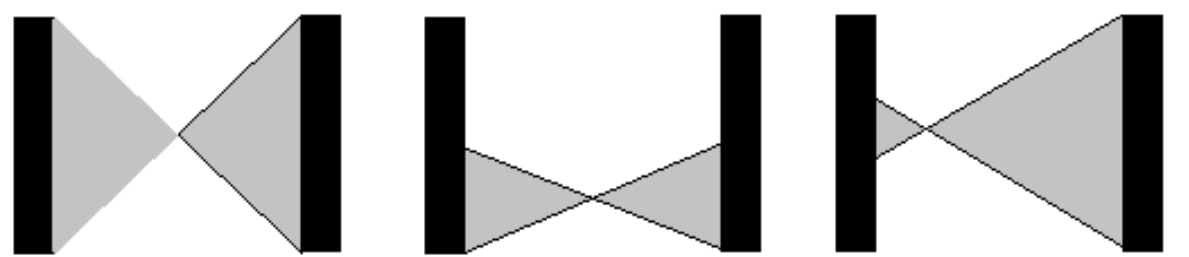
Figure 1. The solid angle for detecting pairs of back-to-back photons is maximum for a source at the centre of the FOV ( left ). As the source moves transverse to the detectors, the angular acceptance falls approximately linearly ( centre ). Movement of the source along the axis between the detectors leads to a smaller reduction in angular acceptance, which is limited by the solid angle of the farther detector ( right ).